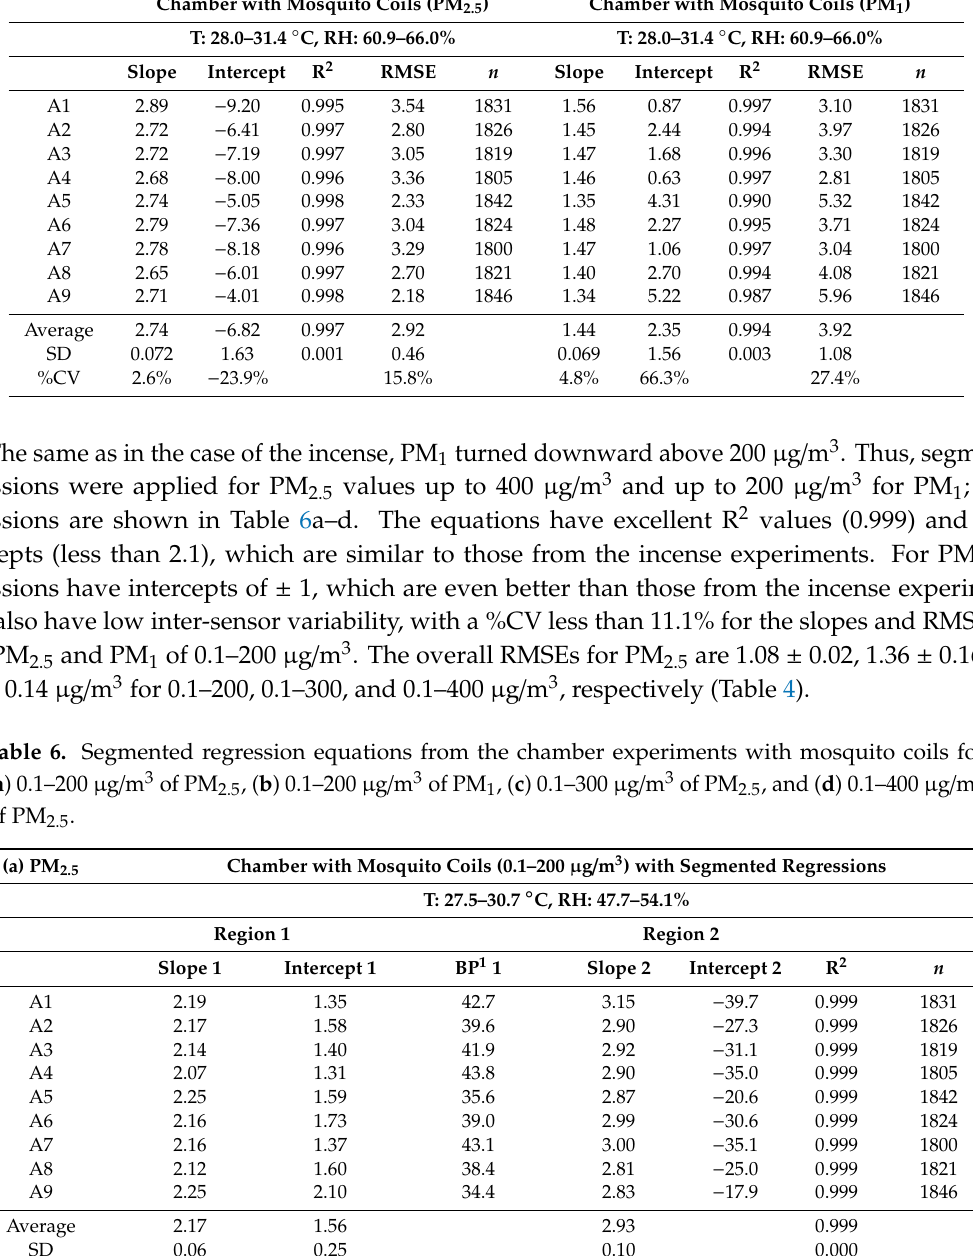
Table 5. Linear correction Equations from the chamber experiments using mosquito coils with 9 AS-LUNG-P sets for PM 2.5 and PM 1 in a range of 0.1–200 µ g / m 3 . Chamber with Mosquito Coils (PM 2.5 )